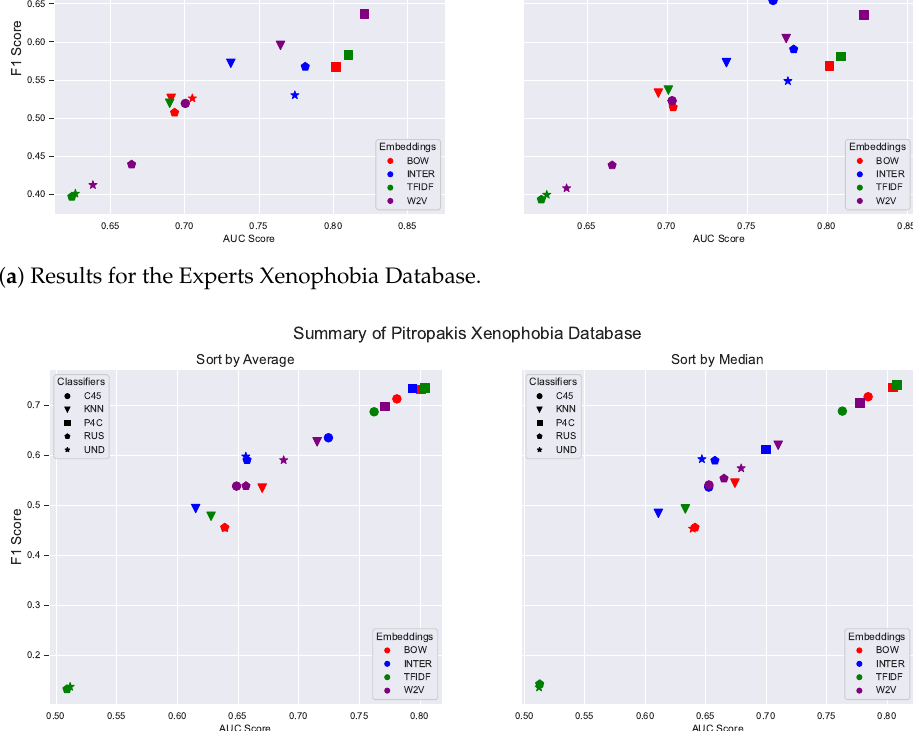
( b ) Results for the Pitropakis Xenophobia Database. Figure 7. The color represents the embedding method, while the shape represents the classifier. The X -axis is the result of the AUC score. The Y -axis is the result of the F1 score. The graphs are ordered by mean and median according to the results of Table